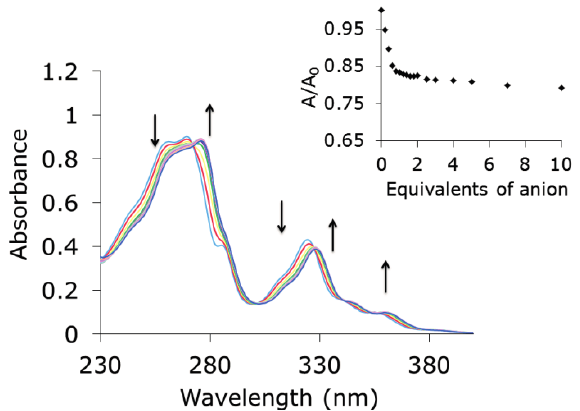
Figure 3. Evolution of absorption spectra upon addition of acetate in acetonitrile.